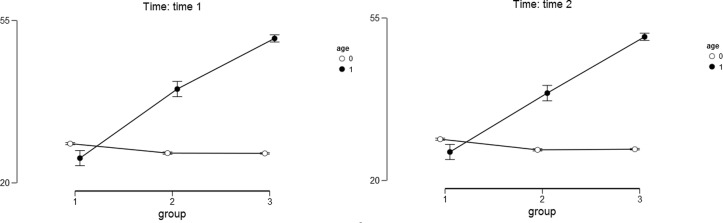
Descriptive statistics for hope as the outcome variable. Age – 0 stands for younger children and 1 stands for older children. Group – 1 stands for control group; 2 stands for placebo group; 3 stands for narrative group. Error bars represent the 95% CI of a mean.